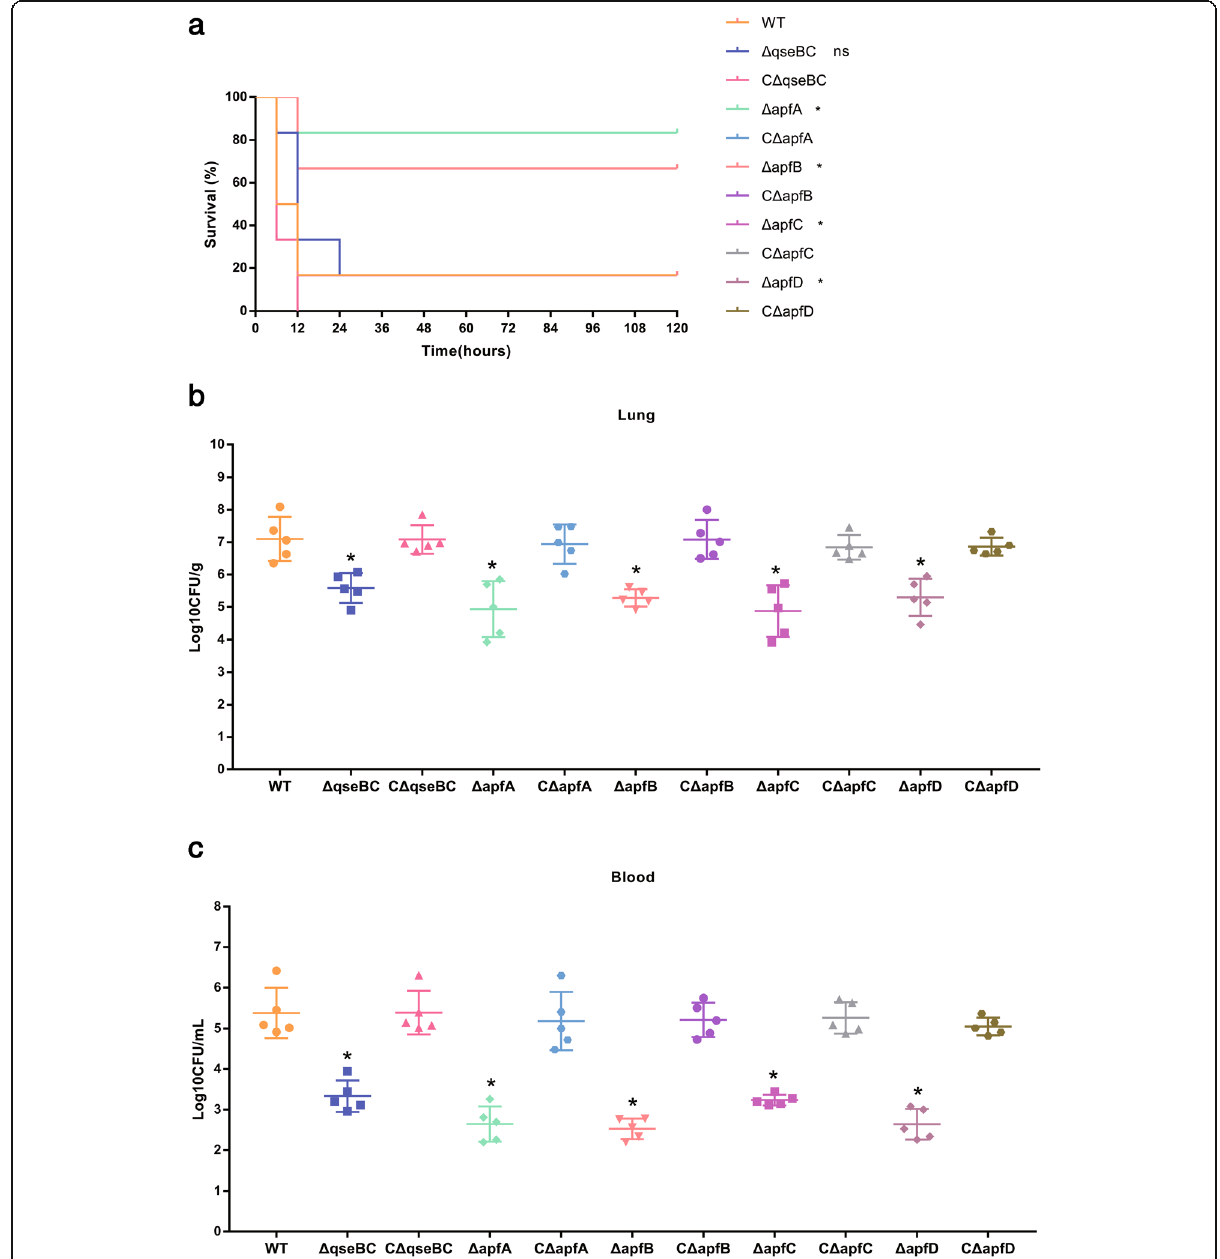
Fig. 7 Survival curves and bacteria loads of mice infected with A. pleuropneumoniae . a Survival curves for Balb/c mouse infected with WT S4074, Δ qseBC , Δ apfA , Δ apfB , Δ apfC and Δ apfD strains. Six-week-old Balb/c mice were inoculated WT S4074, Δ qseBC , Δ apfA , Δ apfB , Δ apfC and Δ apfD strains with 5.00 × 10 6 CFU by intraperitoneal injection, and the survival of mice was monitored for 120 h post-infection. Data were analyzed by log-rank test. b , c The A. pleuropneumoniae load in lung ( b ) and blood ( c ) tissues of infected mouse. Each mice was inoculated WT S4074, Δ qseBC , Δ apfA , Δ apfB , Δ apfC and Δ apfD strains with 5.00 × 10 6 CFU by intraperitoneal injection. * P <